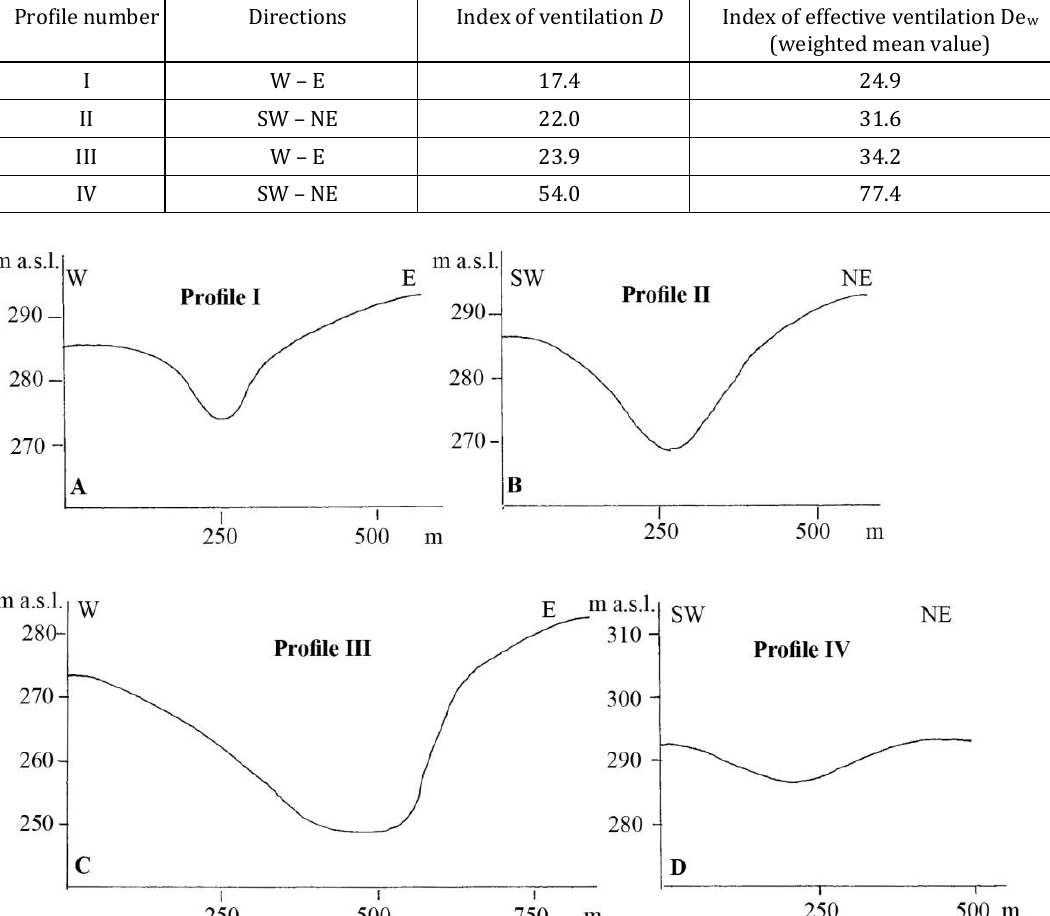
Table 2. Index of ventilation D and weighted mean value of the index of effective ventilation De w for selected transverse profiles through the Szotkówka and Pszczynka valleys